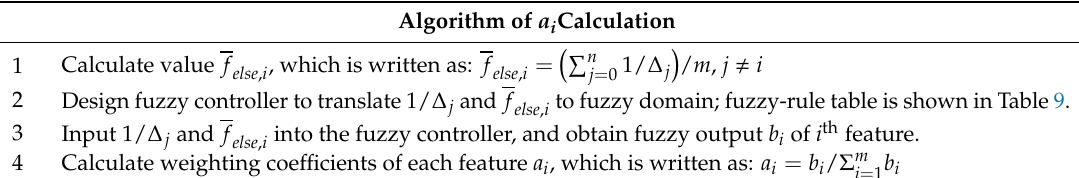
Table 8. Computation procedure of a i . Algorithm of a i Calculation